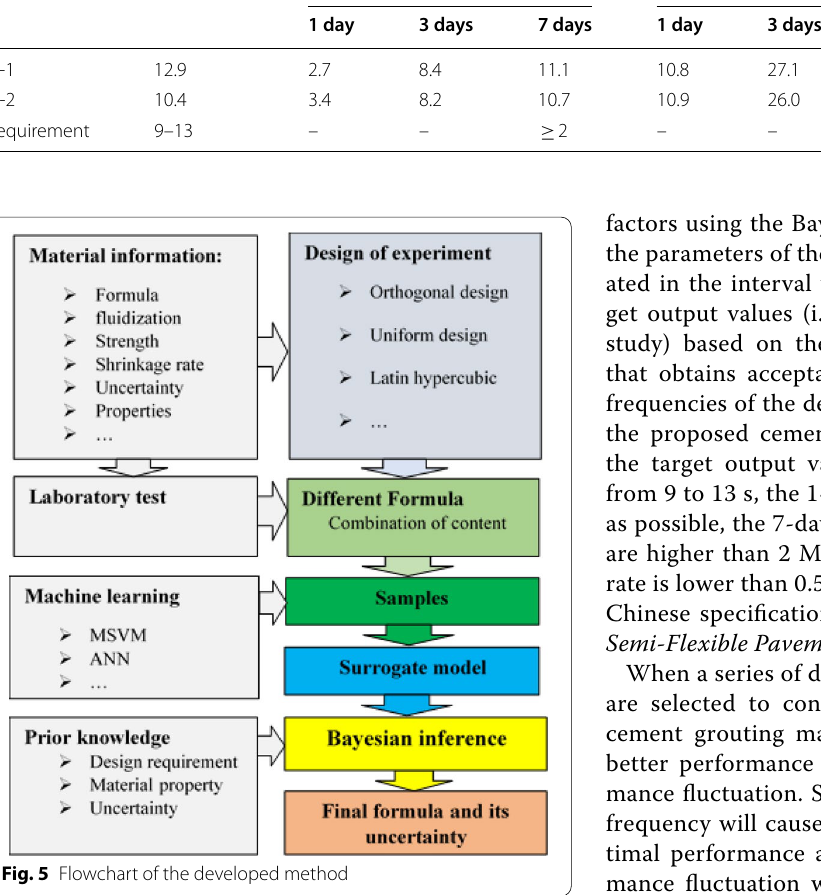
Table 9 Engineering properties of the proposed formula No.